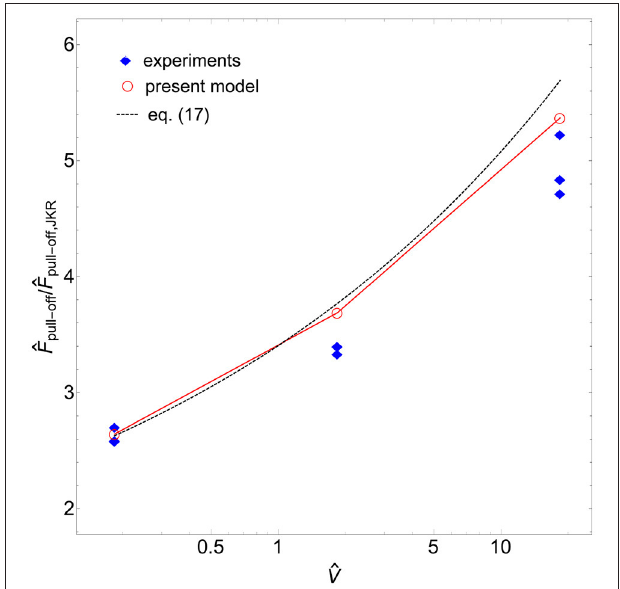
FIGURE 6 | Dimensionless contact radius ˆ a (A) and contact force ˆ F (B) as functions of the dimensionless penetration ˆ δ for ˆ V = 0.1847 ( V = 0.2 µ m/s). Results are given for different initial points of unloading. Loading curve (blach dashed line) is obtained with JKR’s model, while unloading curves are obtained with the proposed solution (red solid line) and Muller’s numerical one (green dashed